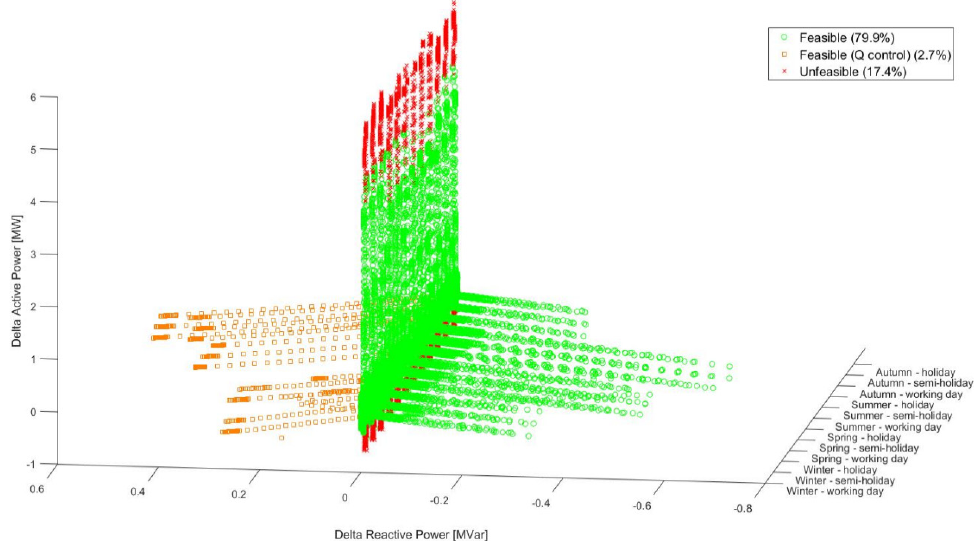
Figure 3. P-Q variations during all the representative days, feeder R1—case A (“only DG”).